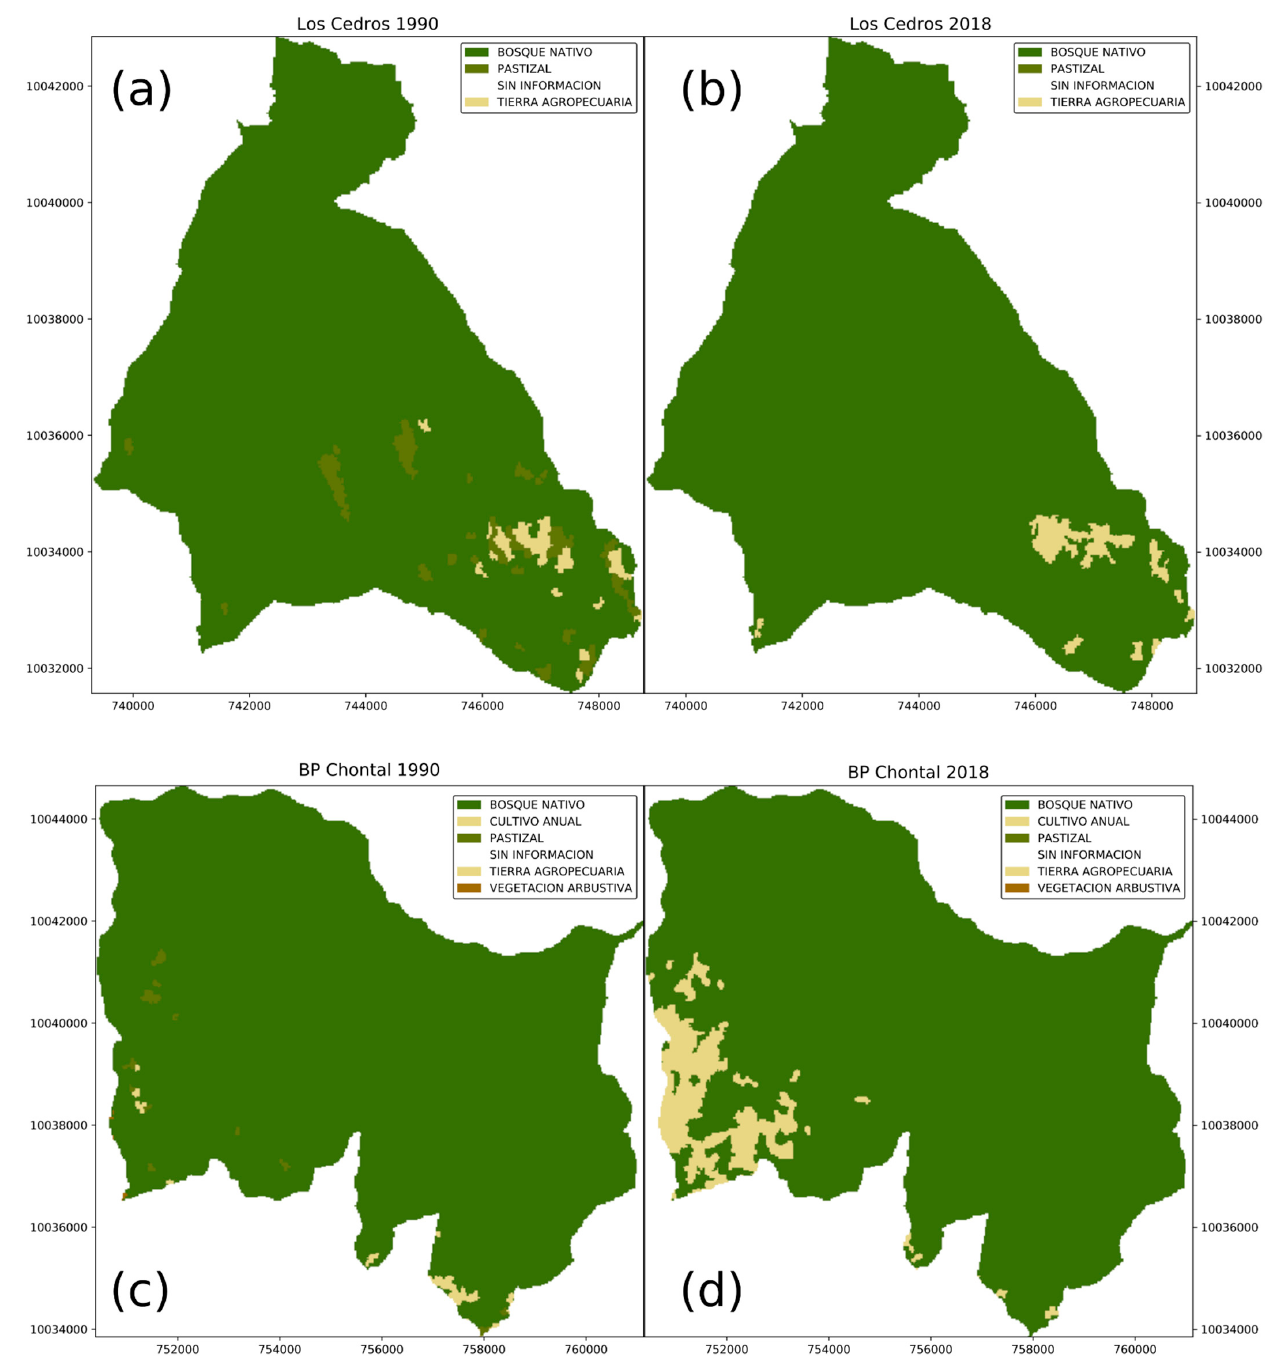
Figure 11. Land-cover changes in Reserva Los Cedros and in nearby protected forest B.P. Chontal. Forest cover is shown in dark green, pasture in tan-green, and agricultural land in beige. Geographic coordinate system is PSAD56 / UTM zone 17S, in meters. ( a ) Los Cedros, 1990; ( b ) Los Cedros,